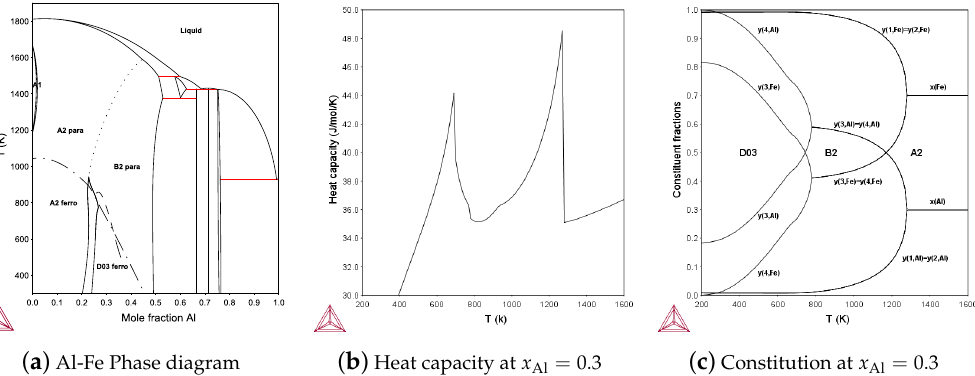
Figure 10. ( a ) The Al-Fe phase diagram with several order–disorder transformations in the BCC phase. ( b ) The heat capacity and in ( c ) the corresponding constituent fractions at x Al =